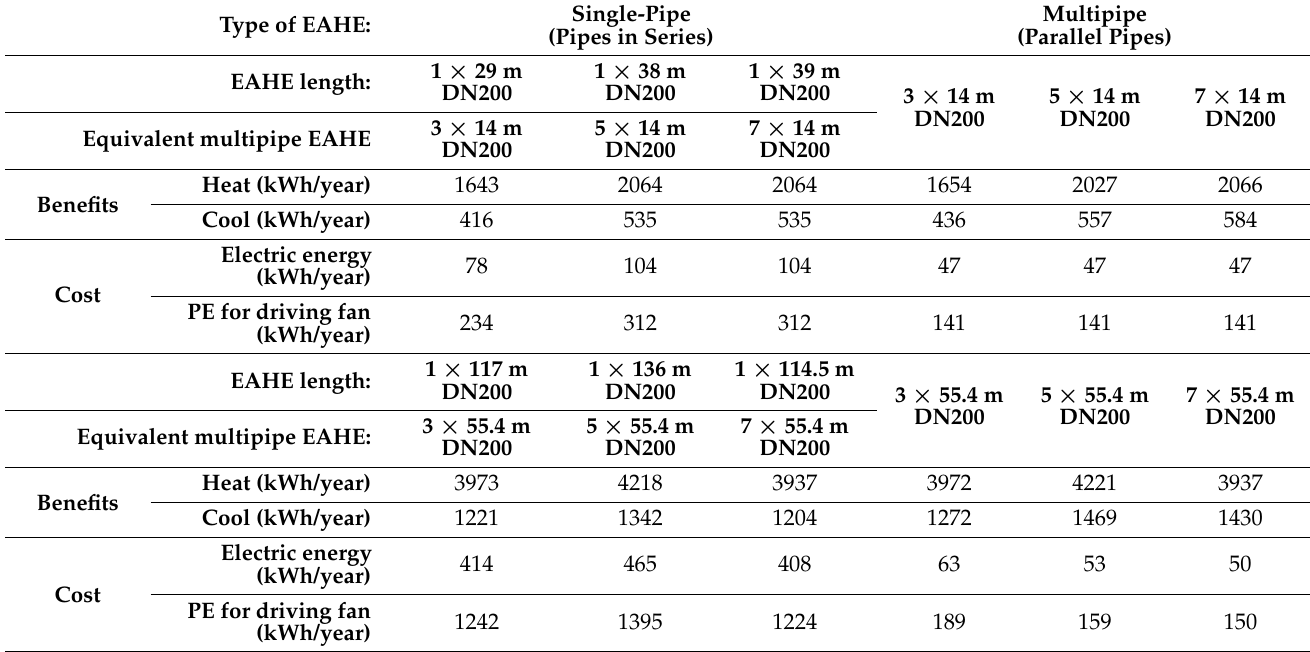
Table 7. Equivalent length of DN200 single-pipe EAHE replacing a given multipipe exchanger in terms of heat; the results of calculations of annual electricity consumption and primary energy consumption for fan drive, V = 600 m 3 /h.